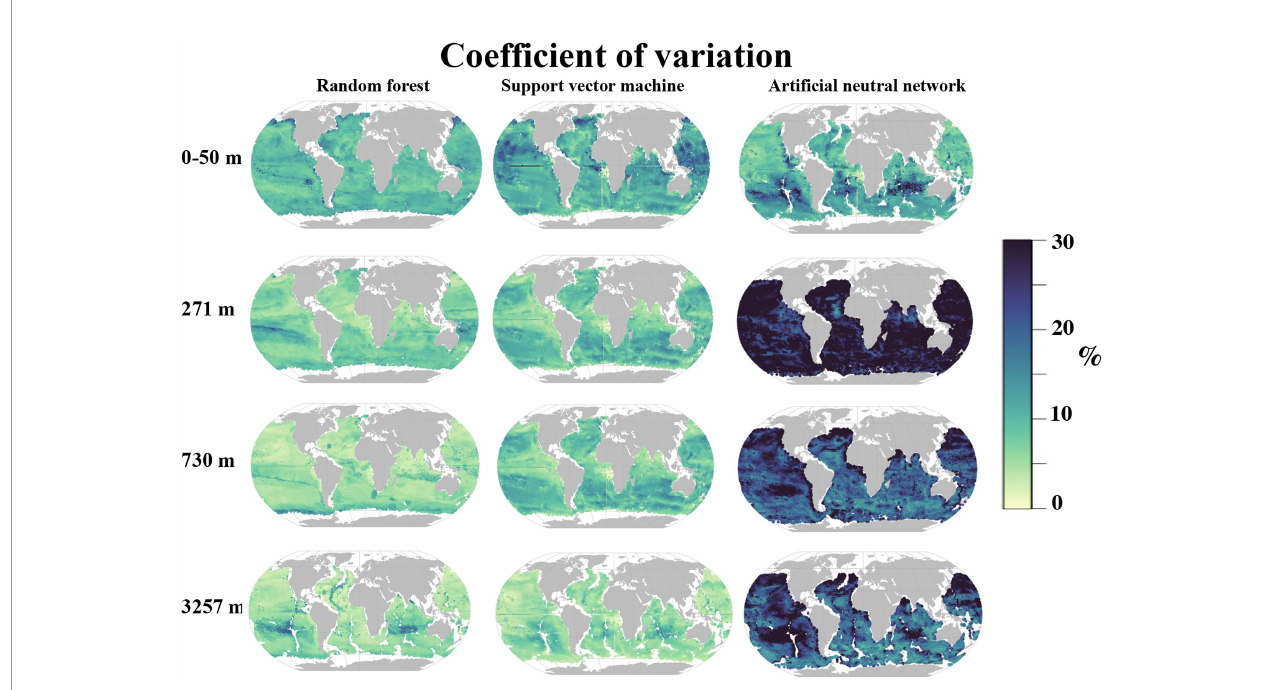
FIGURE 4 | Coef fi cient of variation of projected dissolved Fe calculated from 1000 reconstruction of the training dataset using three machine-learning